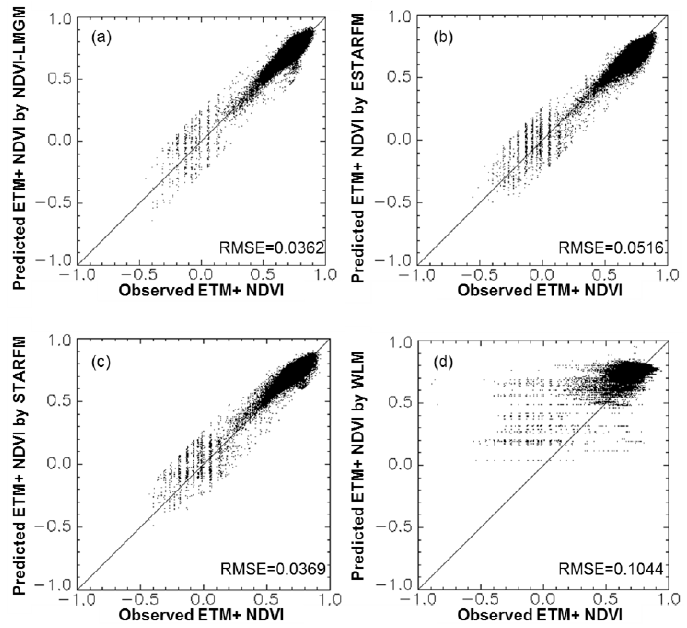
Figure 9. The scatter plot of observed vs. predicted NDVI via the four methods ( a ) NDVI-LMGM, ( b ) ESTARFM, ( c ) STARFM, ( d ) WLM on 11 July